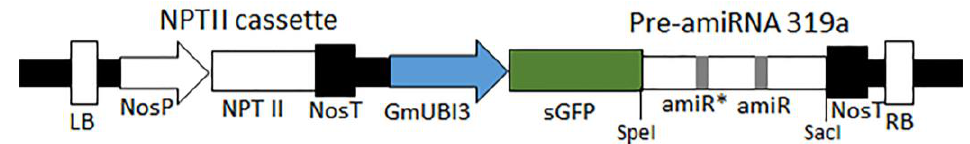
Figure 1. Vector map of pUFamiR construct used for host-derived gene silencing. The artificial microRNA (amiRNA) expression constructs were modified from pBI121 binary vector. The T-DNA region consists of NPTII cassette for kanamycin selection, soybean ubiquitin promoter (Gmubi3), superfolder green fluorescent protein (sGFP) reporter gene fused with the precursor amiRNA (pre-amiRNA) sequences, and the nopaline synthase (NOS) terminator at the 3’ end. The specific amiRNA for each target gene was generated by exchanging the sequences of the amiR guide and passenger (amiR*) strands within the pre-amiRNA319a gene.